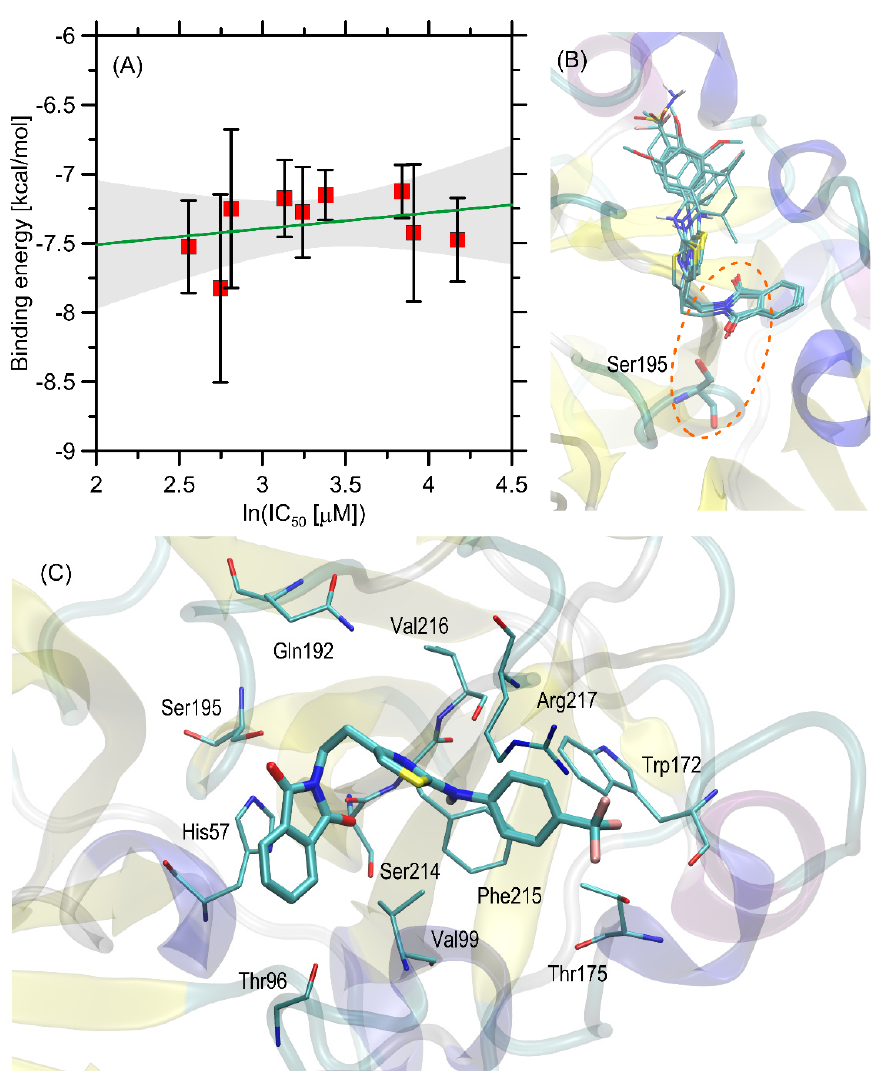
Figure 4. ( A ) The correlation between the calculated binding energies, averaged over the five elastase structures available in the PDB database and the corresponding (experimental) values of IC 50 (recalculated as log(IC 50 )). The horizontal bars represent the standard deviation values within the set of binding energies. The green solid line represents the linear regression (with 95% confidence intervals filled in grey) ( R = 0.41; p < 0.27). ( B ) The superposed positions of all studied ligands (stick representation, colored by atom type) in the binding cavity of the 1bma structure of elastase. All these positions were identified as the optimal ones during the standard (non-covalent) docking procedure. 0.3 nm. ( C ) The location of the 4c ligand molecule bound to the 1bma structure of elastase and